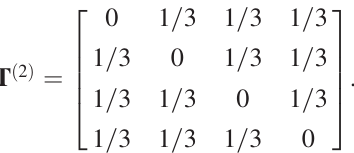
FIG. 12. Scenario 5. Normalized Kullback-Leibler divergence D ð m Þ between X ð t Þ and its Markovianized surrogate Y ð t Þ for a two-layer multiplex, where the second layer is a replica of the first layer in which a number of shortcuts have been introduced. When no edges have been introduced, both replicas are identical, X ð t Þ is Markovian, and D ð m Þ ¼ 0 ∀ m ; otherwise, the process is non- Markovian, and the algorithm detects multiplexity by finding D ð m > 2 Þ > 0 . Such detection improves as the topology of both layers is increasingly